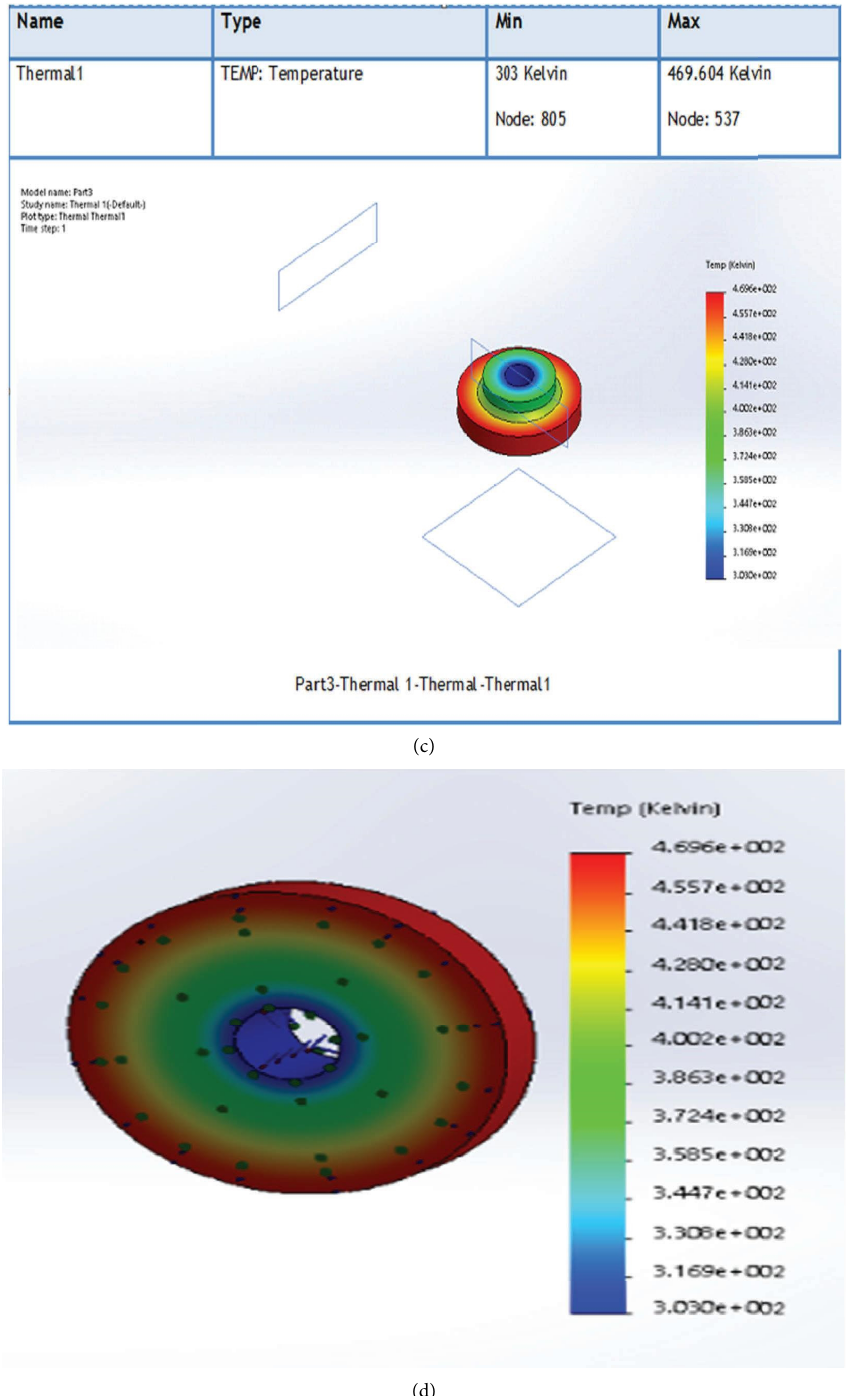
Figure 11: (a) Disc brake plate model; (b) meshing of disc brake plate model; (c) thermal analysis (top view); (d) thermal analysis (bottom